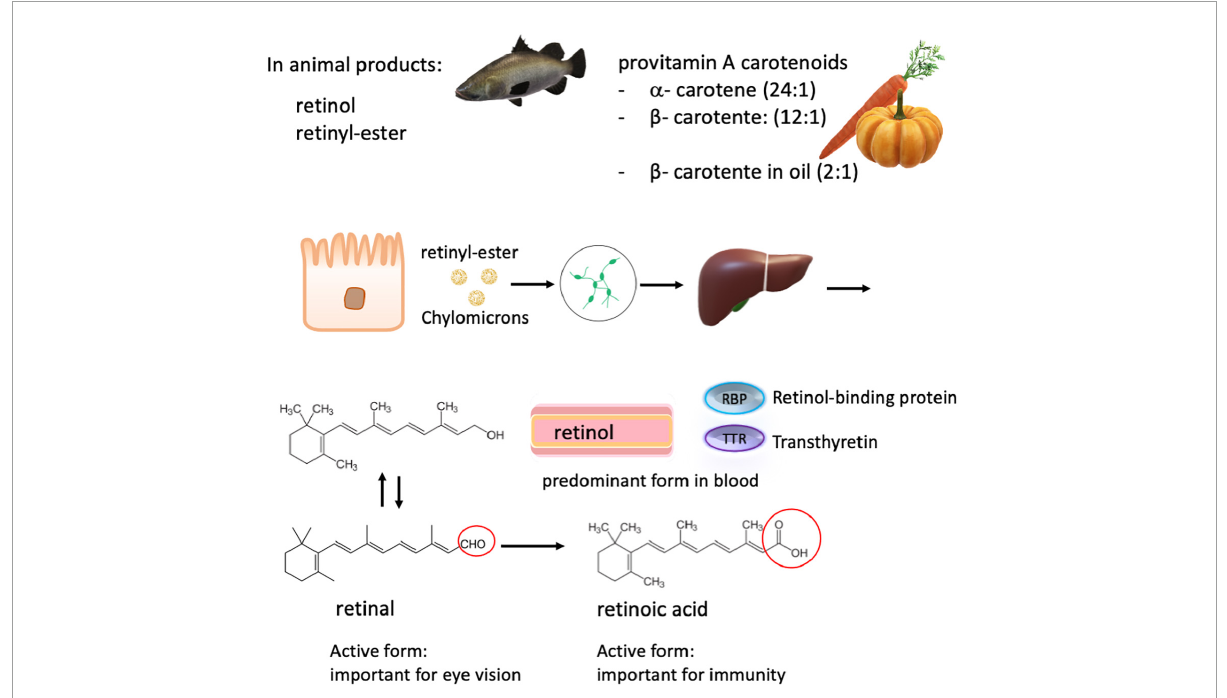
FIGURE3 Carotenoids and retinoids metabolism. Total vitamin A intake consists of many dietary forms including free retinol, retinyl esters from animal sources, and plant-derived α - and β - carotenes, which have a lower bioavailability. The conversion rate of carotenes to retinol is in brackets. The various ingested forms of vitamin A are then processed, stored in the liver, and can be released into the systemic circulation on demand. Retinol is the major form present in the blood, which is transported by retinol-binding proteins (RBP) to the target tissue. In the circulation, RBP binds to transthyretin, probably to evade loss by glomerular filtration. Retinol is converted into retinal and retinoic acid, respectively. Retinoic acid is responsible for most of the activity of vitamin A, except for visual pigment effects that require